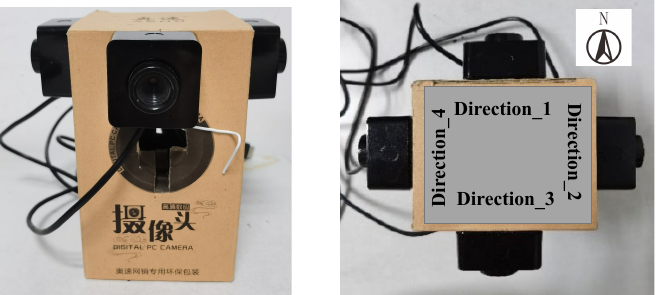
Figure 7. Multi-directional images collection equipment.(( Left ): front view, ( Right ): top